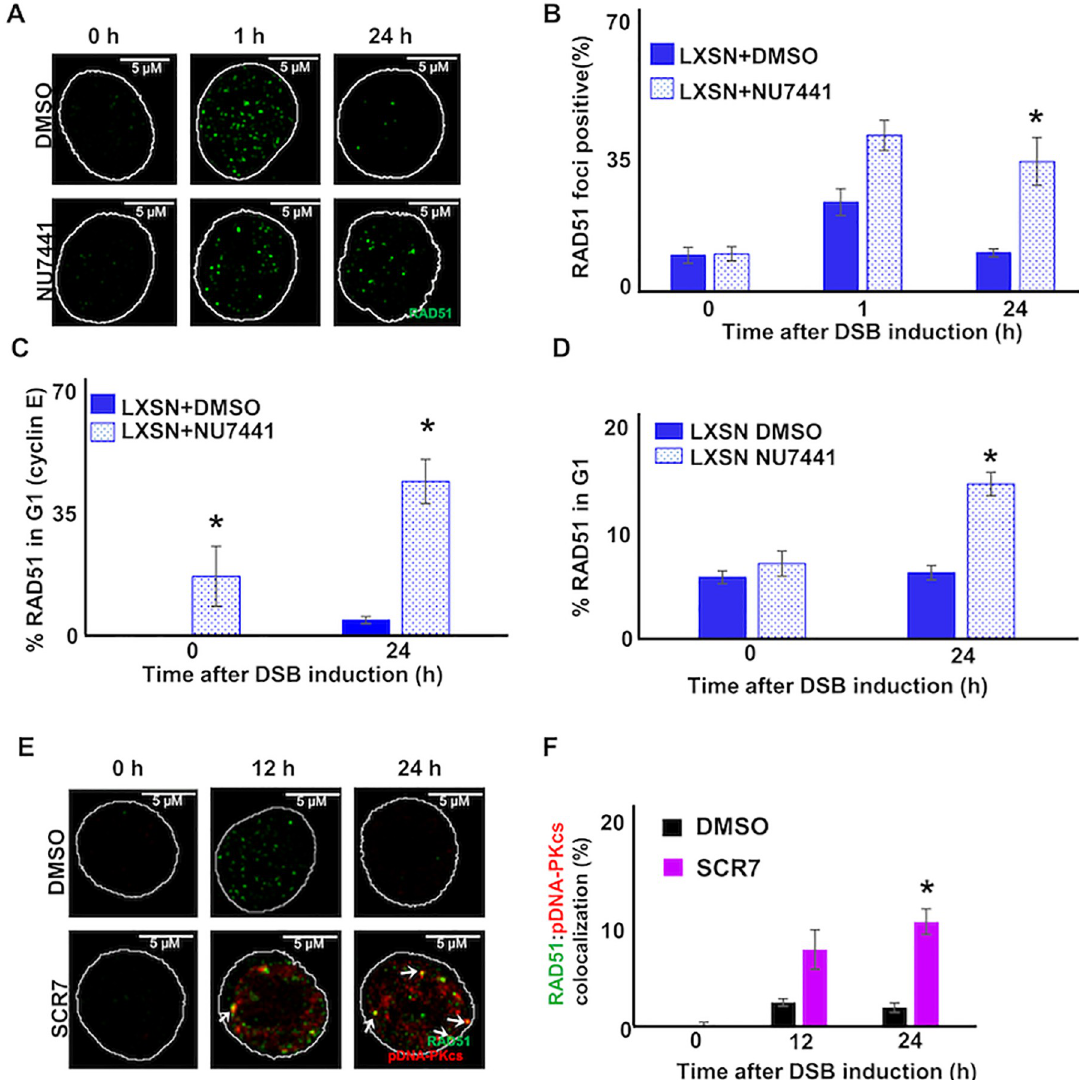
Fig 6. DNA-PKcs inhibition increases RAD51 foci in G1. (A) Representative images of HFK LXSN cells treated with NU7441 (1 μ M) or DMSO stained for RAD51 (green) following zeocin treatment (10 μ g/mL, 10 min). (B) Percentage of HFK LXSN cells treated with NU7441 (1 μ M) or DMSO stained with RAD51 foci following zeocin treatment. (C-D) Percentage of HFK LXSN cells treated with NU7441 (1 μ M) or DMSO stained with RAD51 staining in G1 as determined by (C) cyclin E staining or (D) flow cytometry. (E) Representative images of HFK LXSN cells treated with ligase IV inhibitor (1 μ M of SCR7) or DMSO stained for RAD51 (green) and pDNA-PKcs (red) following zeocin treatment. (F). Percentage of HFK LXSN cells with colocalized RAD51 and pDNA-PKcs foci after treatment with ligase IV inhibitor or DMSO and exposure to zeocin. White arrow indicates colocalization. All values are represented as mean ± standard error. The statistical significance of differences between treatments were determined using Student’s t-test. � indicates significant difference between control (DMSO) and inhibitor treated groups with same zeocin treatment (p < 0.05). At least 150 cells were counted over three independent experiments for microscopy. Twenty thousand cells were counted for each of three independent flow cytometry experiments. Nuclei were determined by DAPI staining. The edge of this staining is shown by a white line depicting the nucleus.